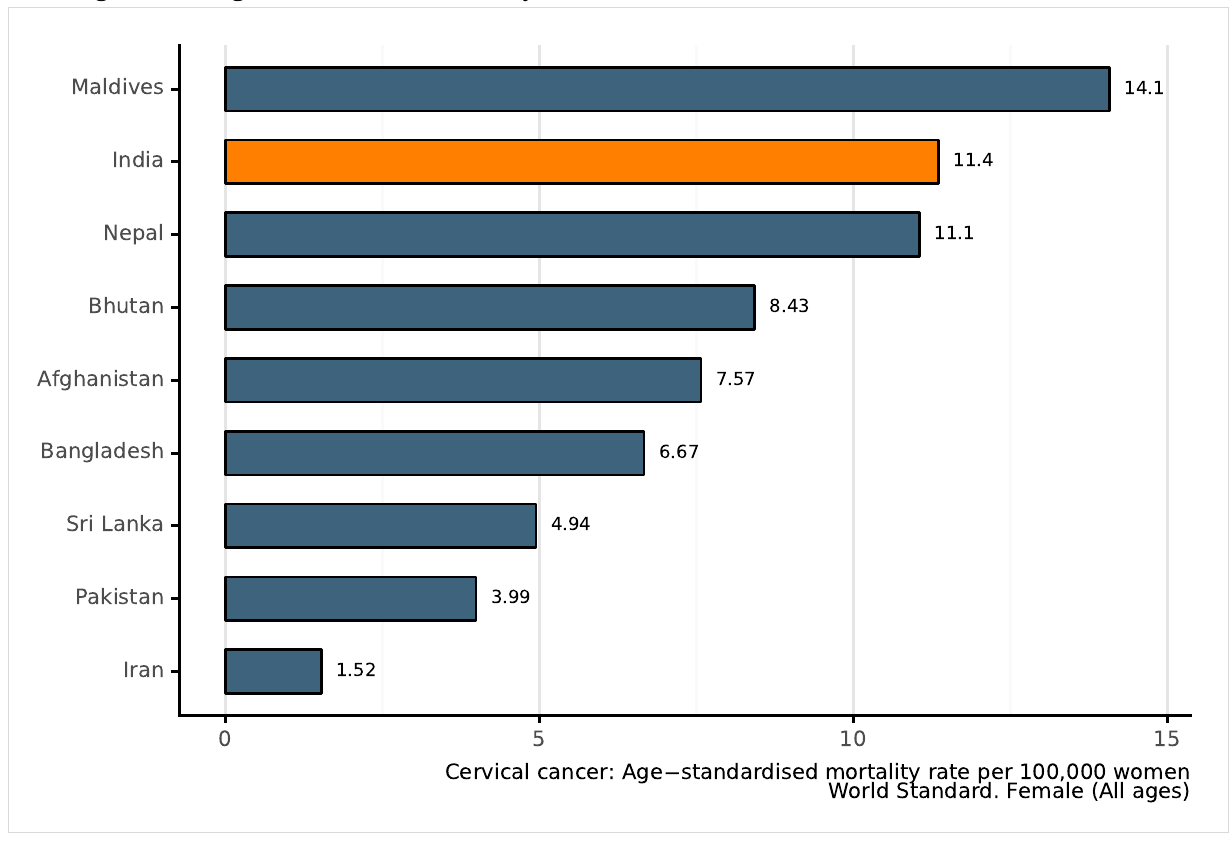
Cervical cancer: Age standardised mortality rate per 100,000 women World Standard. Female